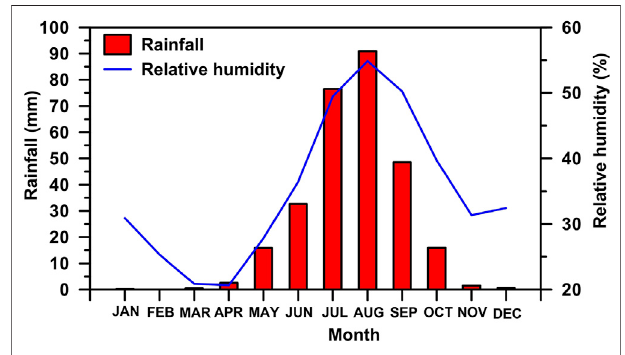
FIGURE6| Themonthlyvariationinmean rainfalland relative humidityin Sudan between 1981 and 2010.